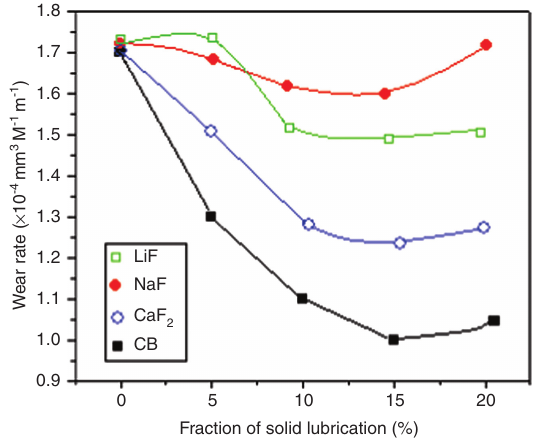
Figure 9 Wear rate with different fluoride solid lubricant and differ- ent addition